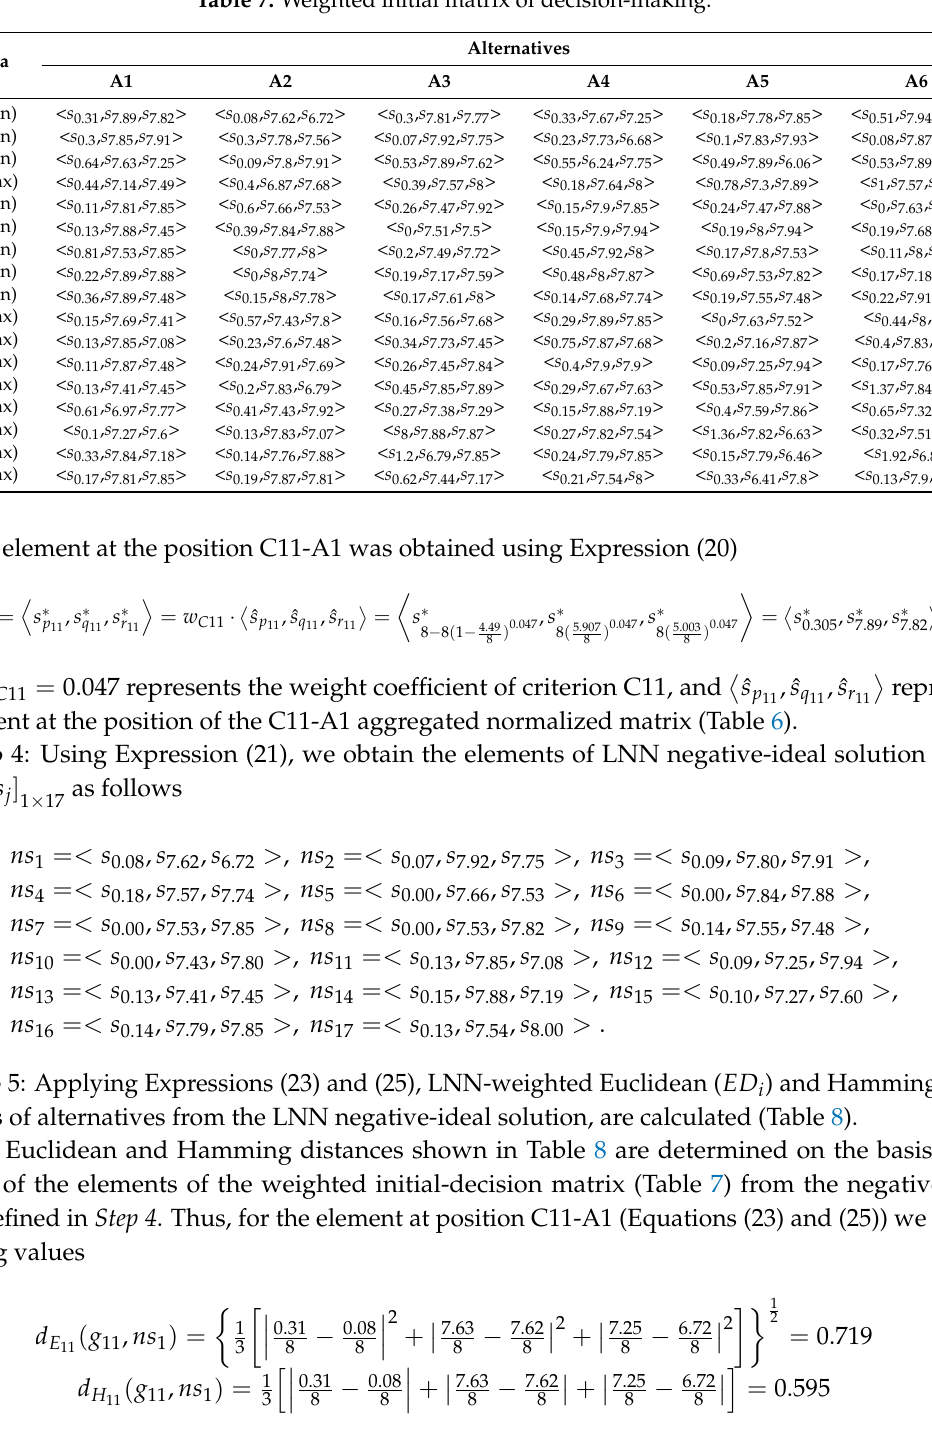
Table 7. Weighted initial matrix of